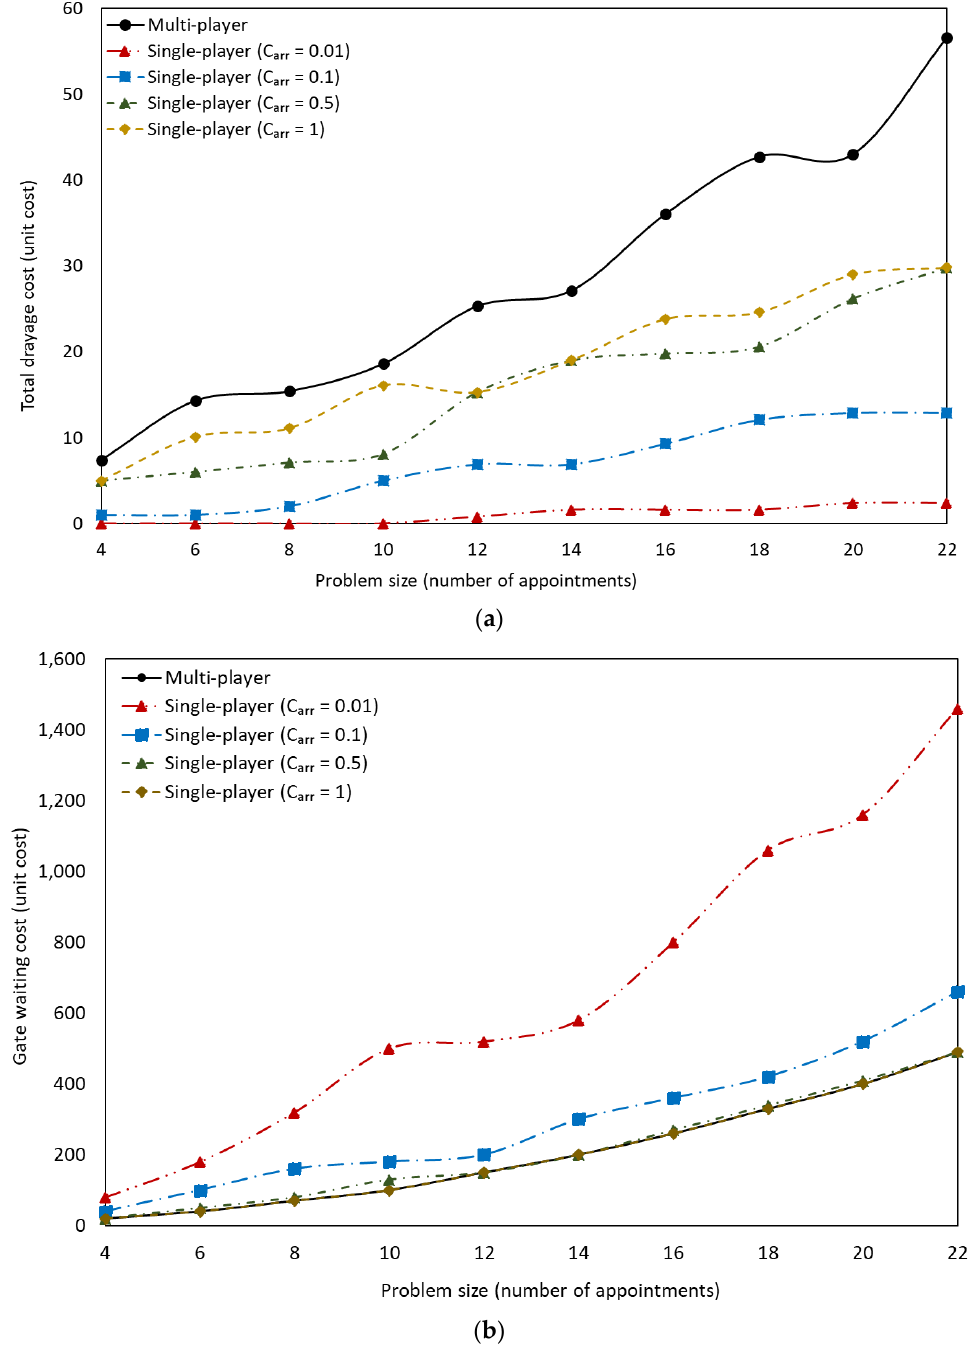
Figure 5. Total drayage cost ( a ) and post-calculated gate waiting cost (without considering C arr in the last term of Equation (55)), ( b ) as a function of problem size.